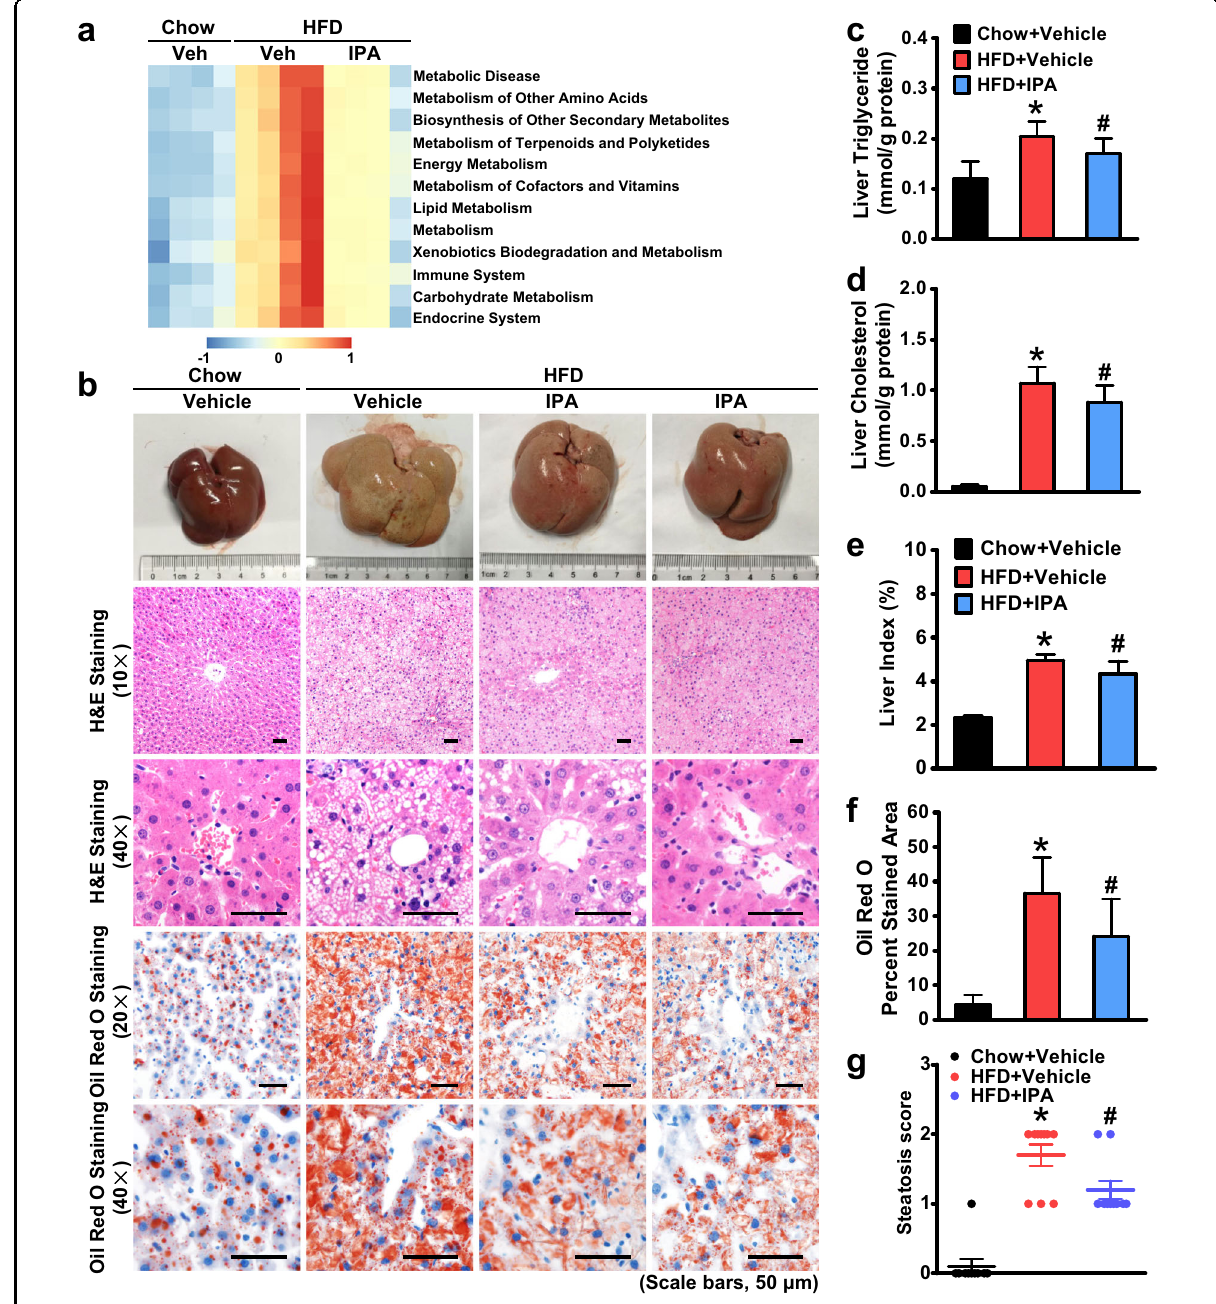
Fig. 3 Administration of IPA protects against hepatic steatosis and restores metabolic homeostasis in rats fed a high-fat diet. a IPA alters metabolic pathways in the gut microbiota of HFD-fed rats. Prediction of the functional genes in the sampled bacterial community was performed using PICRUSt ( n = 4). b Representative gross pictures of the livers and hematoxylin and eosin and oil red O staining of the liver sections are shown (scale bars, 50 μ m). Hepatic triglyceride ( c ) and cholesterol ( d ) levels were assessed in rats. e The liver index was calculated. f Quanti fi cation of oil red O-stained areas is shown. g Steatosis score based on the SAF score algorithm was measured. The data are presented as the mean ± SEM. n = 7 – 10, * P < 0.05, vs. rats fed a chow diet; # P < 0.05, vs. rats fed a high-fat